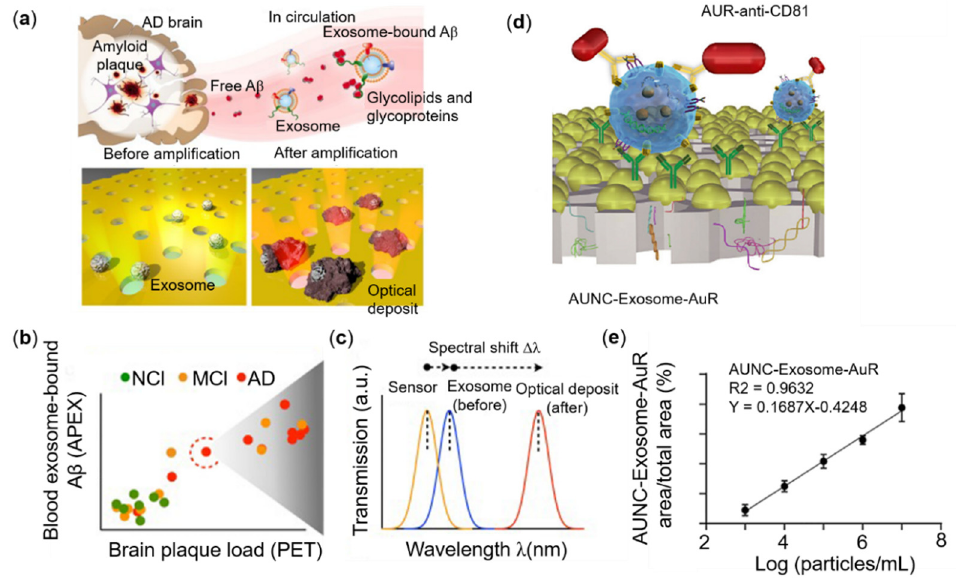
Figure 4. Performance of different nanostructures and sensing performance for exosomes. ( a ) Exo- somes associate with A β proteins. The A β protein, the main component of amyloid plaques found in AD brain pathology, is released into the extracellular space. Exosomes are nano-scale outer cell membrane vesicles secreted by mammalian cells. Exosomes bind to the released A β protein through their surface glycoproteins and glycolipids ( b ) The APEX platform was used to measure exosomal- bound A β in blood samples of Alzheimer’s disease (AD), mild cognitive impairment (MCI), and no cognitive impairment (NCI) control groups. The blood measurement results are correlated with the corresponding PET imaging of cerebral amyloid plaque deposition. ( c ) A representative schematic diagram of the change transmission spectrum with APEX magnification. The APEX platform monitors the specific exosome binding (before) and the subsequent amplification spectrum (after) transmission spectrum shift ( Δλ ). a.u arbitrary unit. ( d ) Schematic illustration of in-situ detection of exosome ( e ) Correlation of AuNC-Exosome-AuR signal ratio against to exosome concentration. Reprinted ( a , c ) with permission from Reference [97]. Reprinted ( d , e ) with permission from Reference [98].